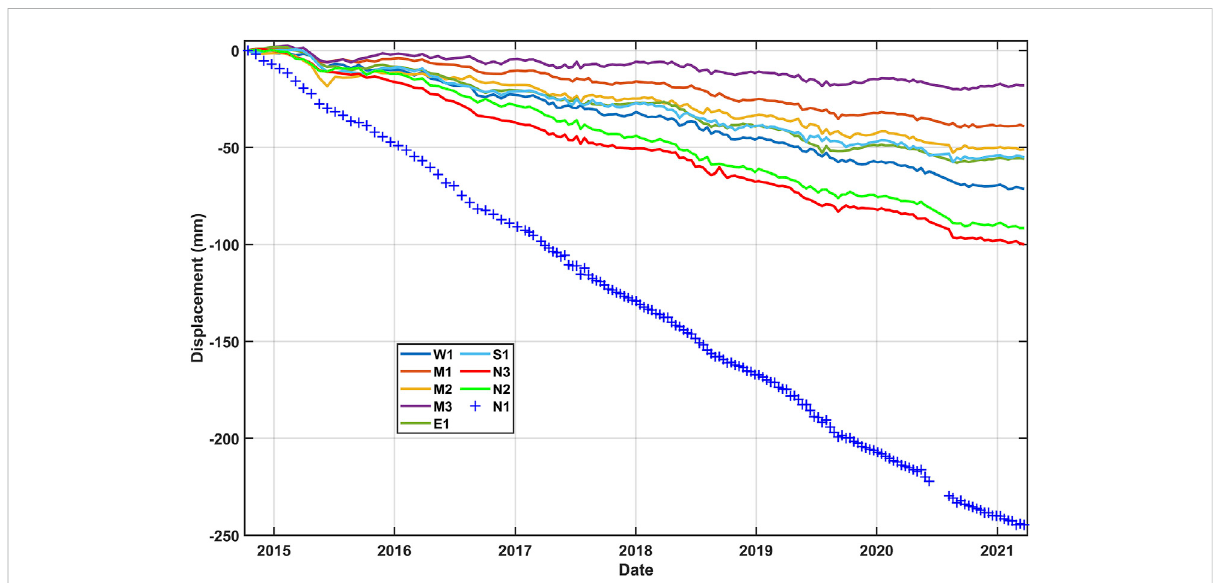
Time-series deformation from October 2014 to March 2021 along the ascending LOS for the regions enclosed in Figure 7. A negative value indicates moving away from the satellite. Time series from N1 is depicted as discrete points to reveal the acquisition dates of all the